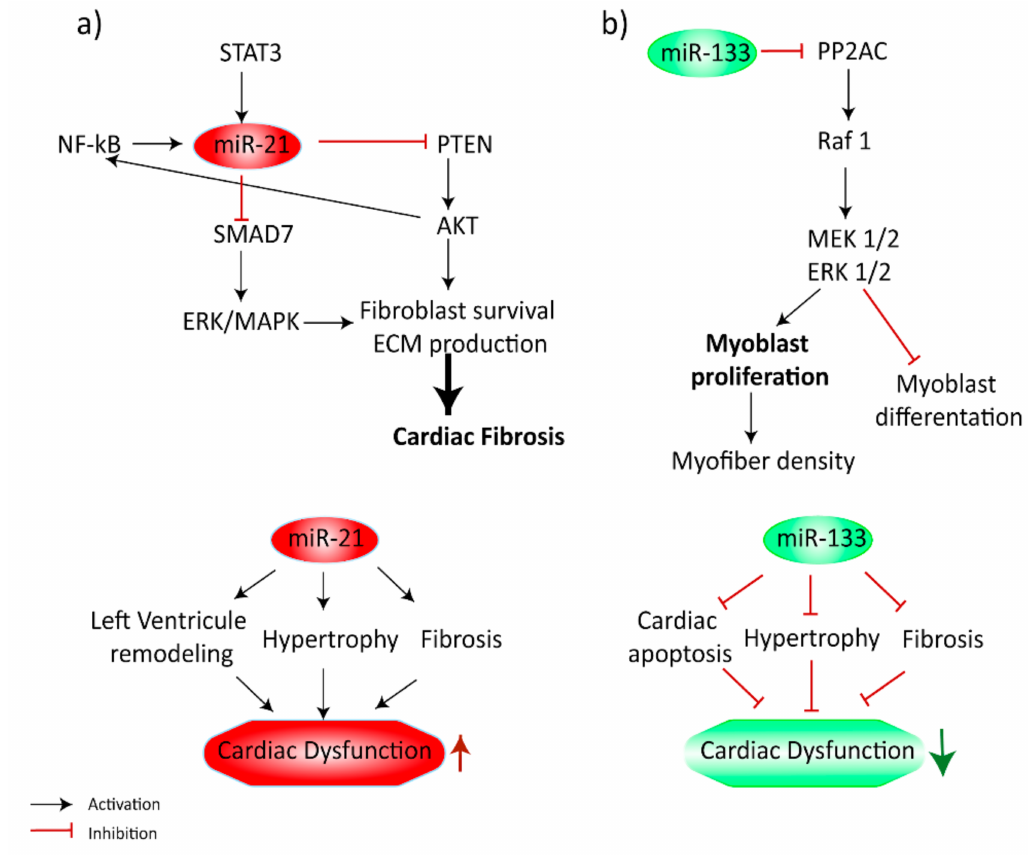
Figure 2. Regulation of cardiac remodeling by microRNAs and the functions of their target mRNAs. MAPK / ERK pathway plays a crucial impact on signal transduction for myosin growth. PI3K / AKT signaling pathway regulates cell proliferation, metabolism, survival, and angiogenesis and controls the development and transformation of left ventricular hypertrophy. The ERK signaling pathway, a member of the MAPK family, comprises a cascade of a series of successively acting kinases. ( a ) The role of miR-21 in cardiac remodeling. Regulation of ERK is mediated by miR-21 via inhibiting PTEN and SMAD7 gene expression. ( b ) The role of miR-133 in cardiac remodeling. MicroRNA-133 plays